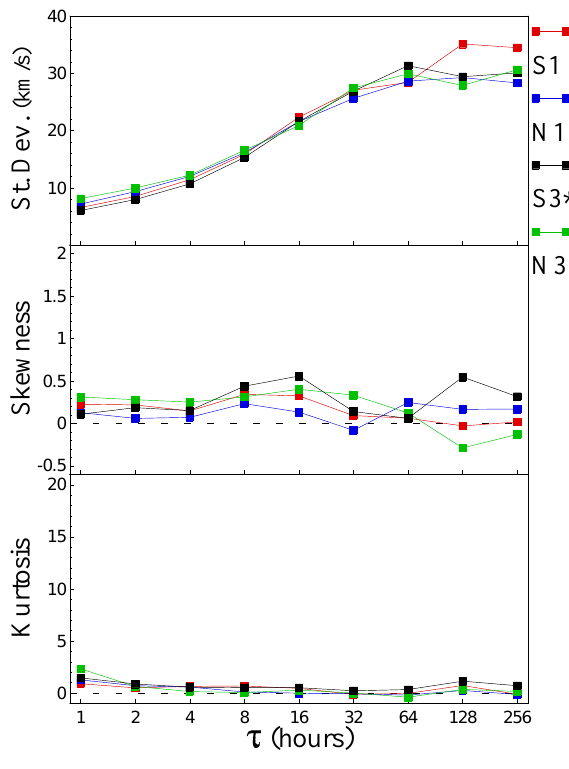
Fig. 6. The top panel shows, in an expanded time scale, the hourly V values for an interval including events A, B, and C. Data plot- ted in red have not been used in a new computation of the velocity differences δV n . The new values of δV 0, δV 1, δV 2, and δV 5 are given in the four lower panels.